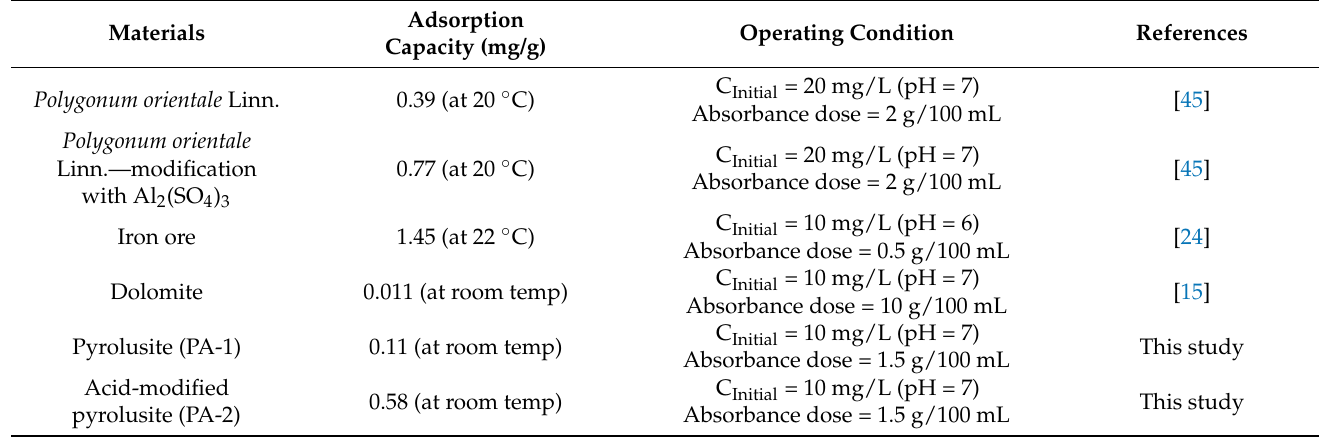
Table 6. Comparison of the differences between the prepared material and the reported literature regarding fluoride